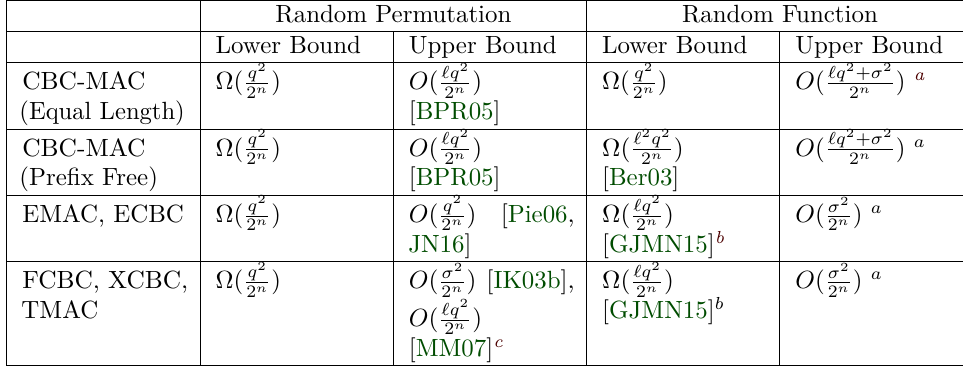
Table 1: Previously known security bounds of CBC-MACs